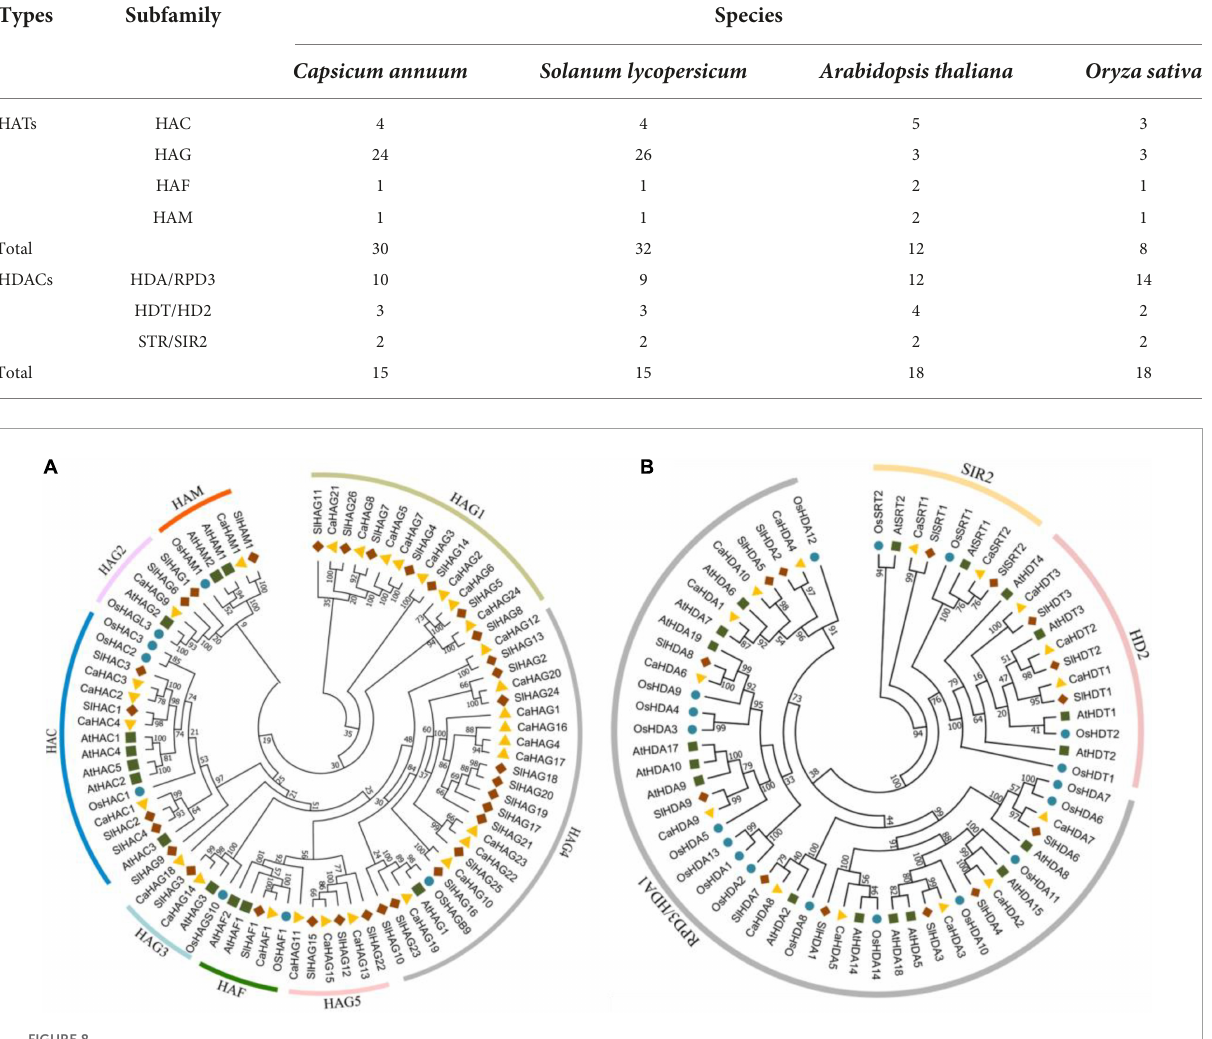
TABLE 1 Number of HATs and HADCs in four plant species.